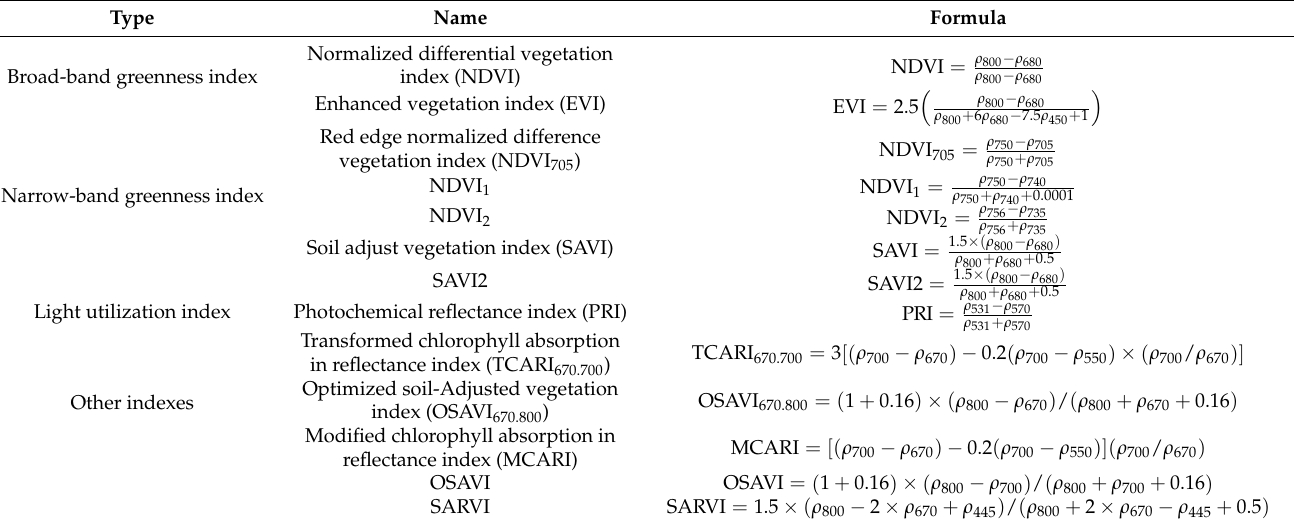
Table 4. List of the vegetation indices for hyperspectral data.